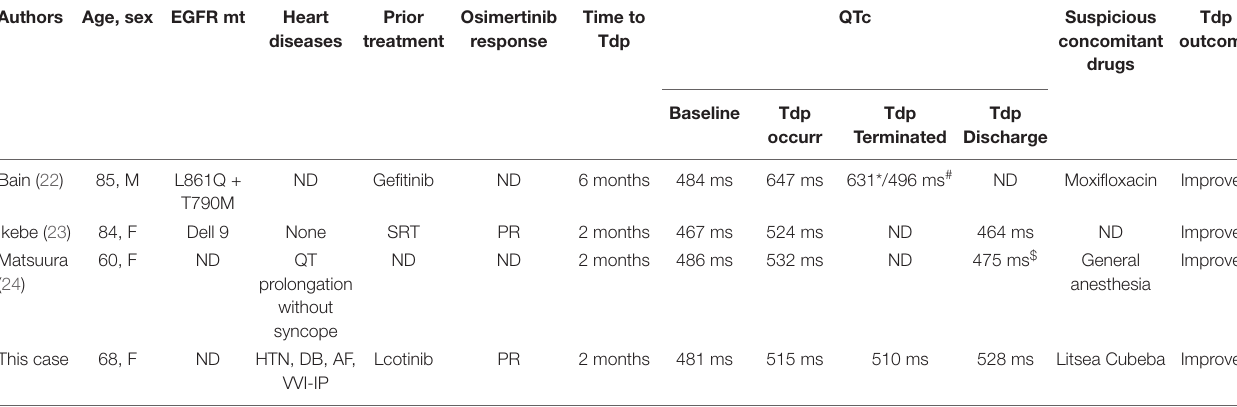
TABLE 2 | Review of case reports of Tdp due to